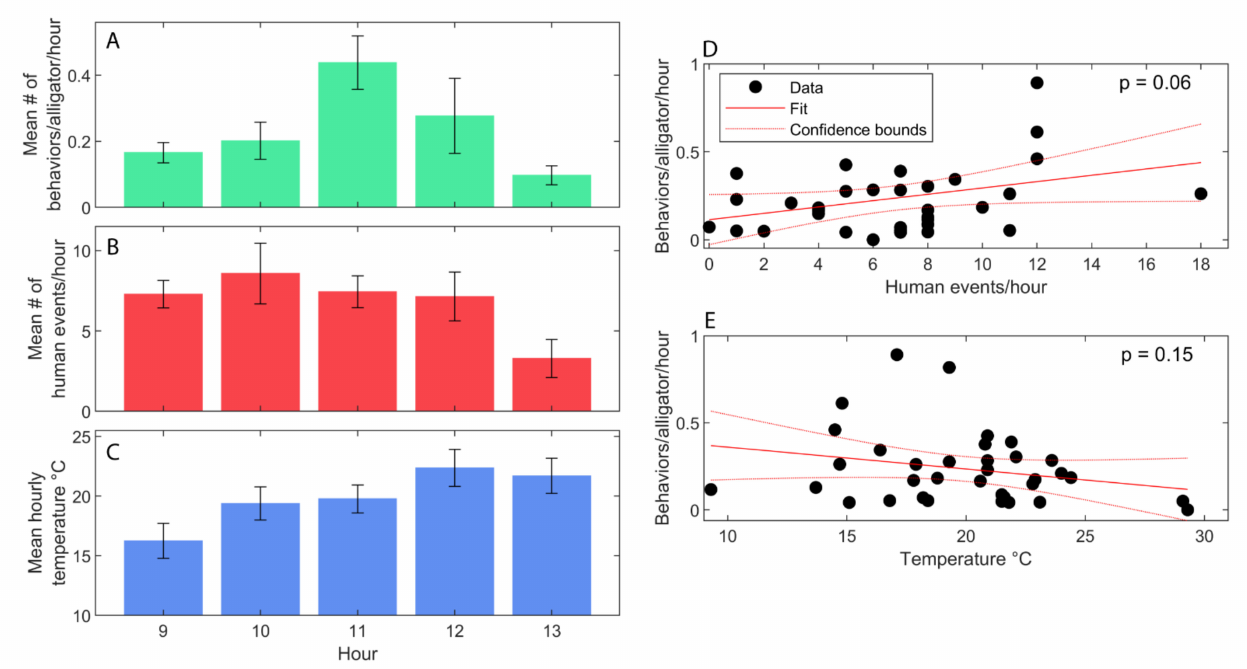
Figure 7. A comparison of trends in behavior, human interactions, and temperature by hour in the wild congregation. ( A ) The mean ( ± SE) number of behaviors (including social and general) divided by group size per hour by hour of day. ( B ) The mean ( ± SE) number of human events (including humans walking near the water or kayaking) per hour by hour of day. ( C ) The mean ( ± SE) hourly temperature ( ◦ C) by hour of day. ( D ) Relationship between the frequency of alligator behavior compared to the frequency of human events. The solid line represents a fitted linear model with the dashed lines representing the 95% confidence interval. ( E ) Relationship between the frequency of alligator behavior compared to the air temperature. The solid line represents a fitted linear model with the dashed lines representing the 95% confidence